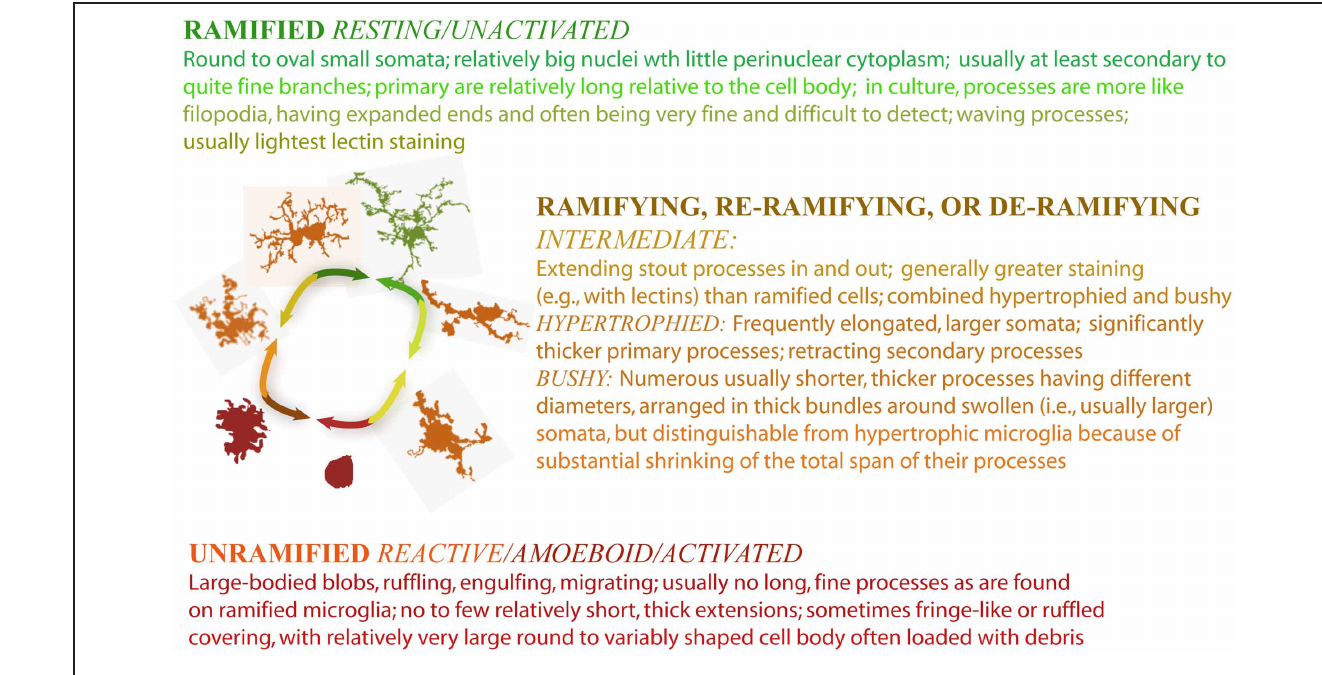
FIGURE 7 | Criteria for morphological categories of